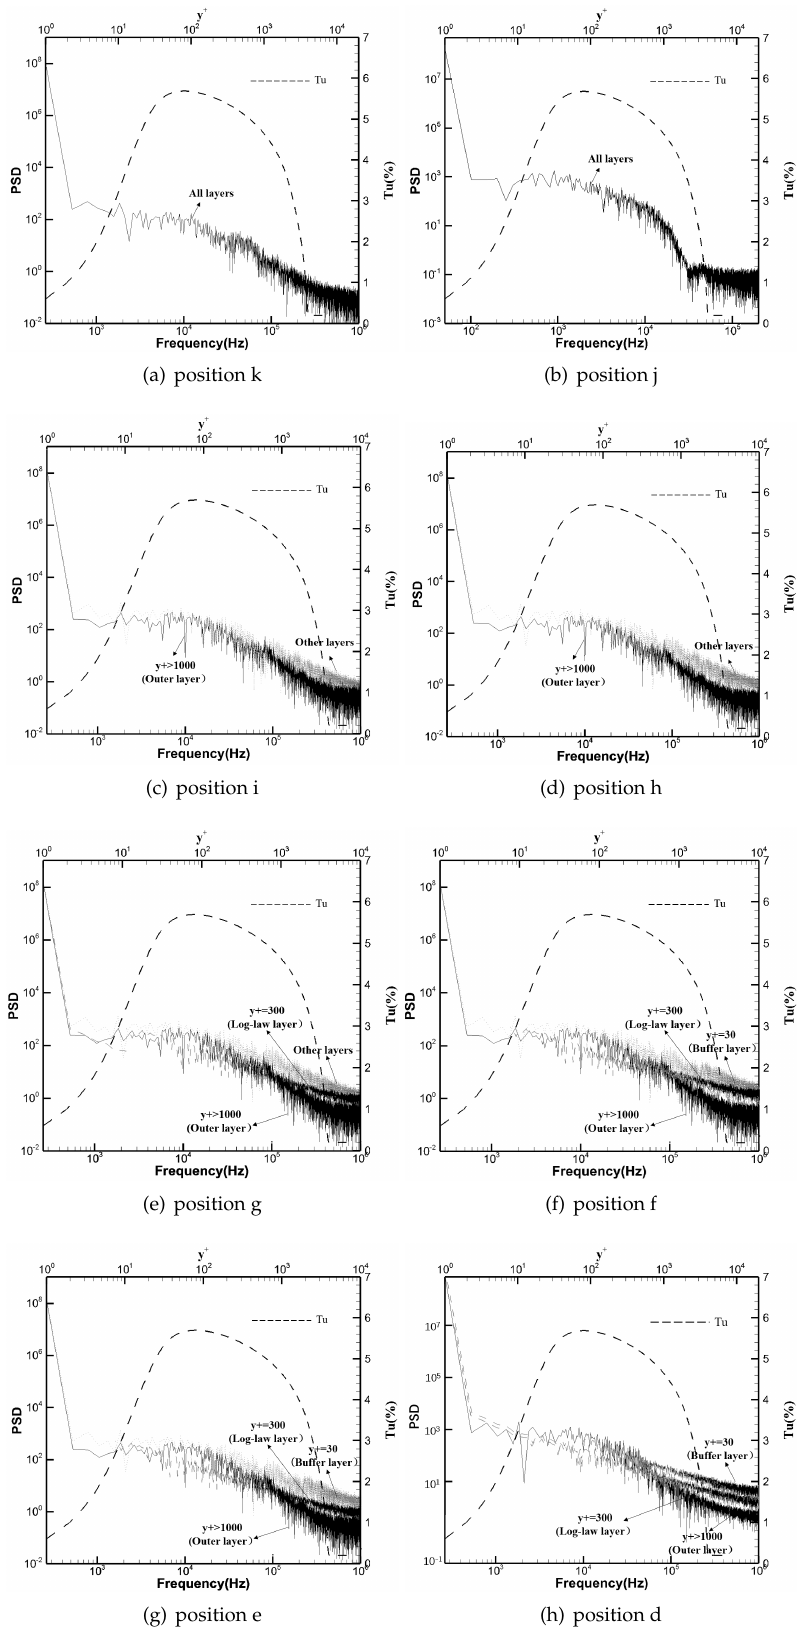
Figure 9. PSD and turbulent intensity at positions